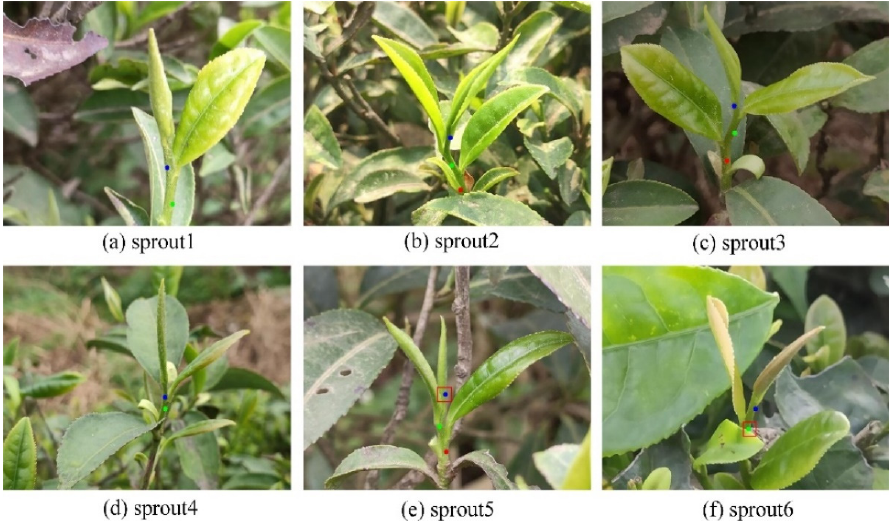
Figure 9. Results of picking point marking. ( a – d ) Correctly marked picking points; ( e , f ) Incorrectly marked picking points.